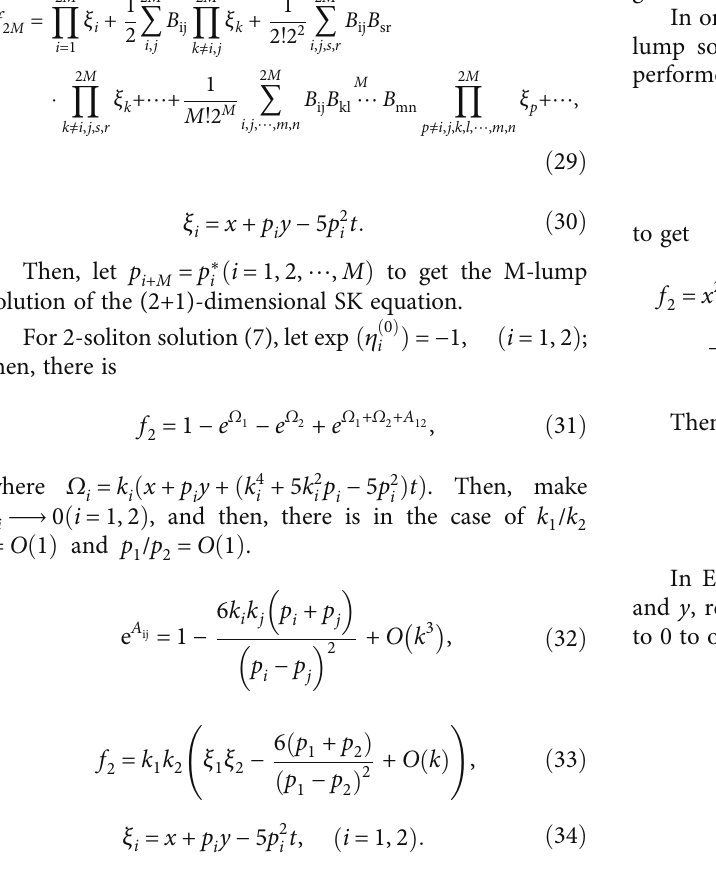
= c = c = c = 0 Þ 11 12 21 22